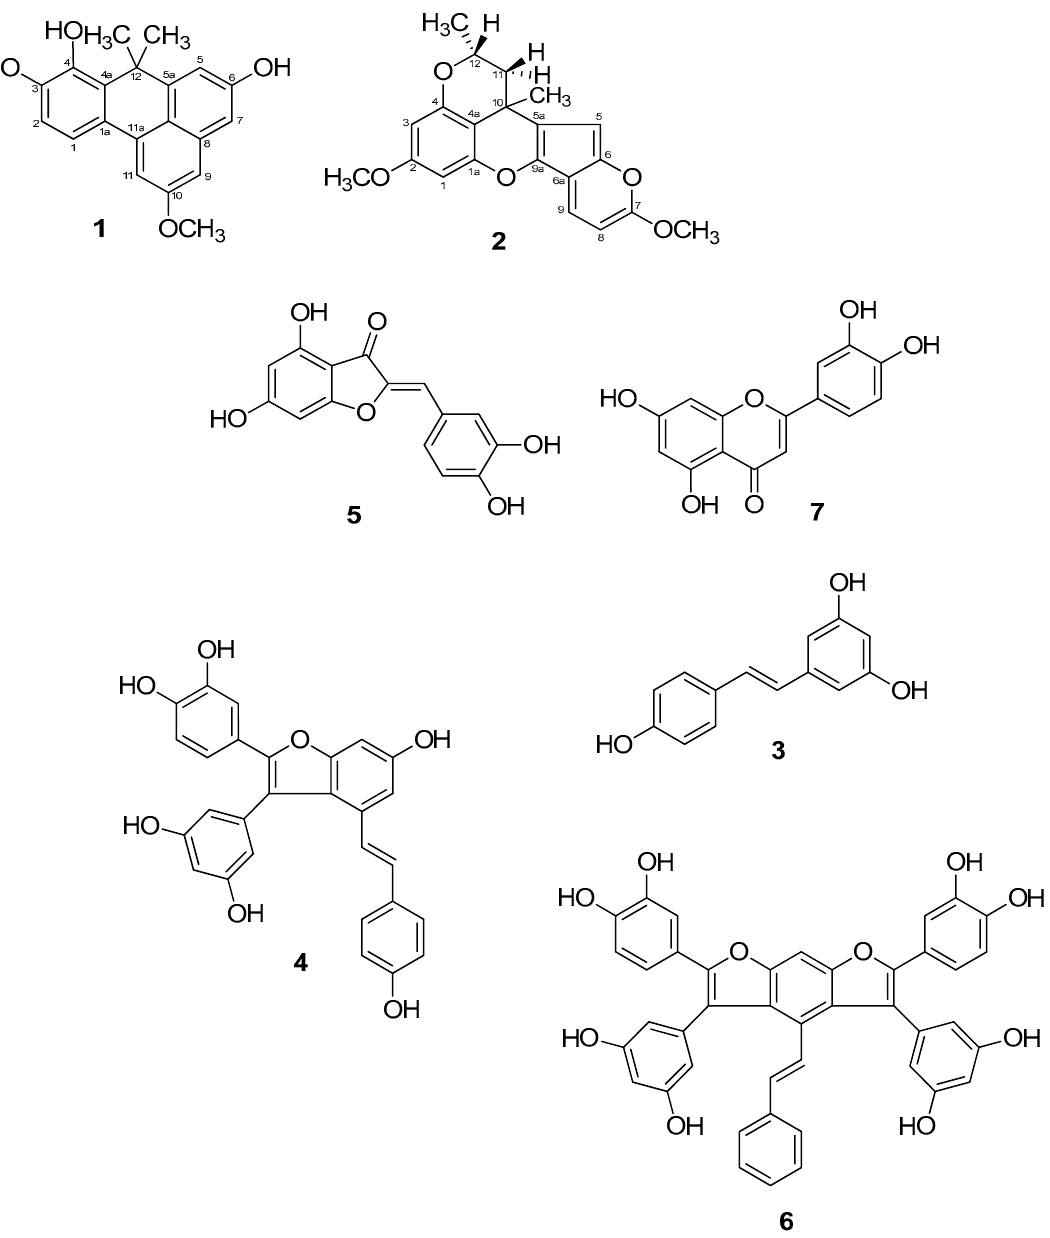
Figure 3. Structures of compounds 1 − 7 .